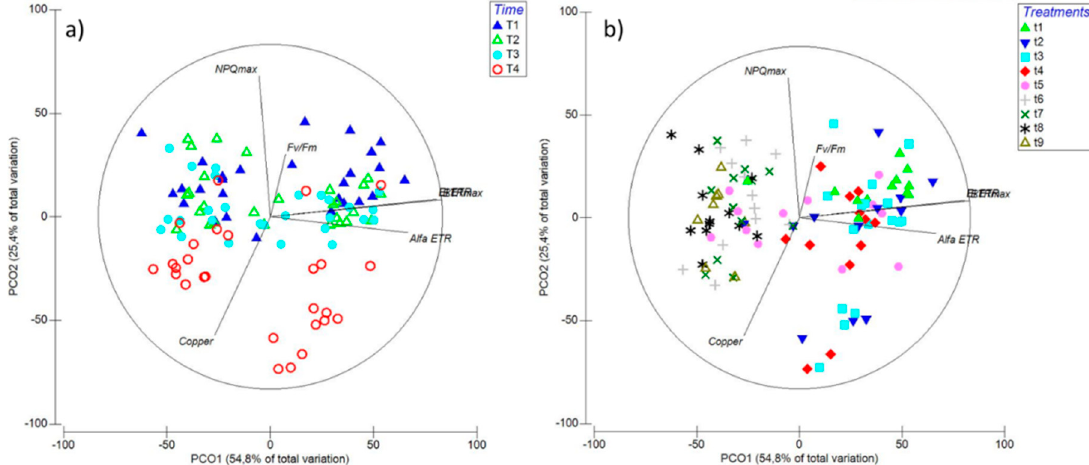
Figure 7. Principal Component Ordination (PCO) analysis diagrams expressed in relation to ( a ) time: